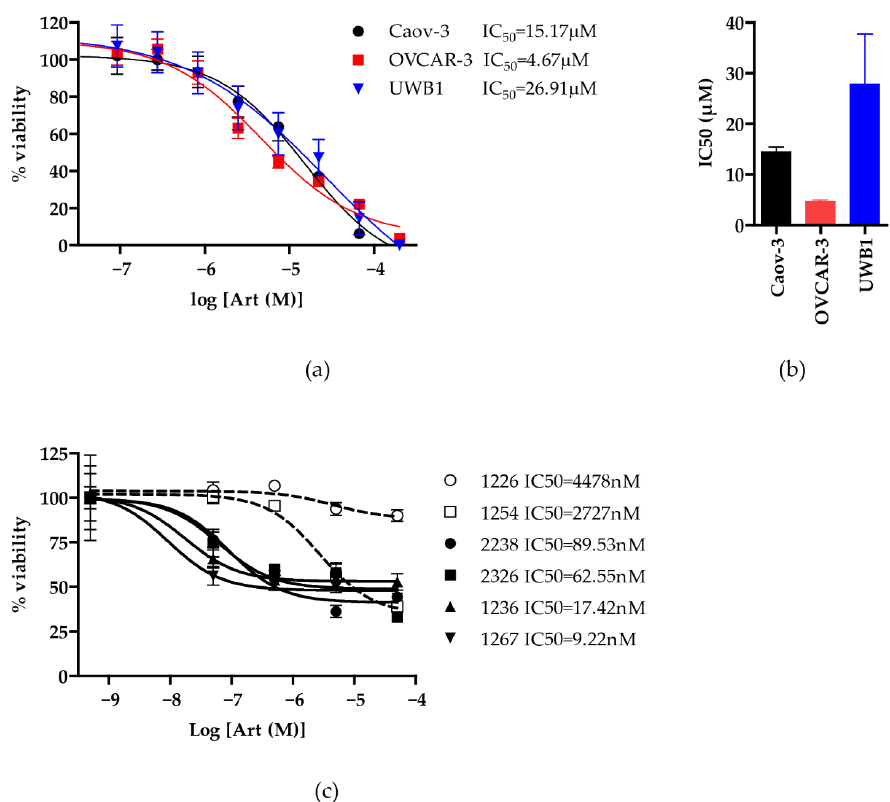
Figure 1. Artesunate sensitivities across 3 commercially available ovarian cancer cell lines and 6 novel 3D ovarian cancer organoids. ( a ) Human ovarian cancer cell lines Caov-3, OVCAR-3, and UWB1.289 cells were treated with serially diluted concentrations of artesunate for 72 h. CellTiter-Glo 2.0 viability assay (Promega) was used to calculate percent viability from the proliferation of treated versus vehicle-treated control cells. The mean +/ − SD from three independent experiments is shown graphically and IC50s were calculated using a variable slope non-linear regression line. ( b ) The mean IC50 of artesunate treatments in each cell line is graphed with SD. Utilizing a one-way ANOVA with Bonferroni’ Multiple Comparison Test, all IC50s were not significantly different with p > 0.05. ( c ) 3D ovarian organoids were established from 6 patients and were treated similarly with serially diluted concentrations of artesunate for 72 h. Viability was measured with MTS assay (Promega) and the signal for each drug treatment was normalized to a matched vehicle-treated control. The mean % viability +/ − SD is shown graphically and IC50s were calculated using a variable slope non-linear regression